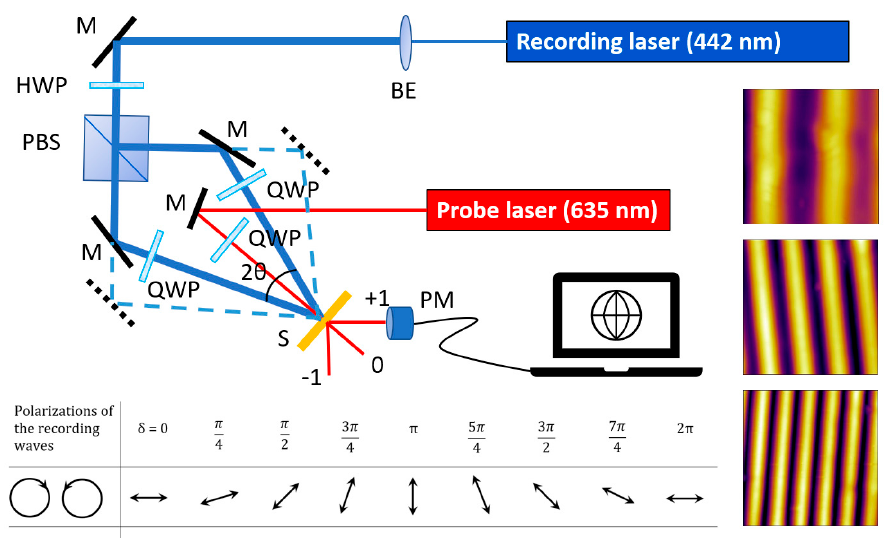
Figure 1. Optical scheme of the polarization holographic setup. BE: beam expander; HWP: half-wave plate; QWP: quarter-wave plate; PBS: polarization beam splitter; M: mirror; S: sample; PM: power meter. The insets show the light interference field on the sample (bottom) and the different surface grating periods that are obtained by varying the recording angle (right).